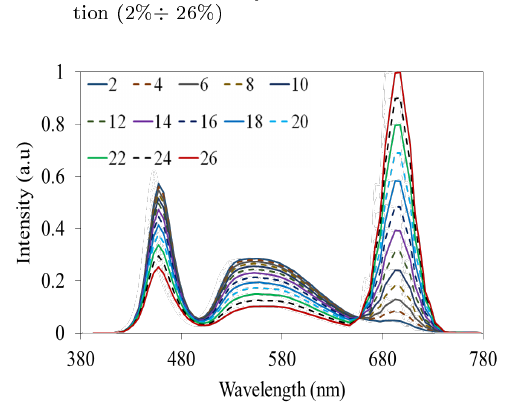
Fig. 7: The emission spectra of 6600 K WLEDs as a function of Sr w F x B y O z :Eu 2+ , Sm 2+ concentra-